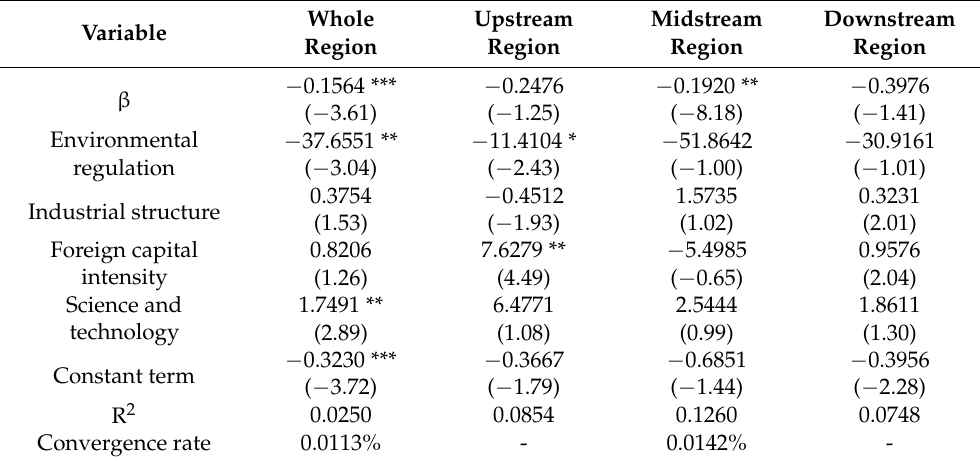
Table 5. β Conditional convergence